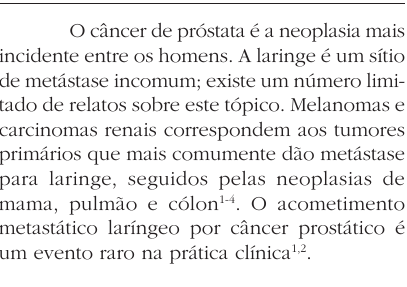
Figura 1. Aumento volumétrico heterogêneo da cartilagem cricoi- de com desmineralização e erosão associada a compo¬nentes de partes moles, promovendo importante estenose da coluna aérea da laringe (setas). (a e b): visão axial sequencial